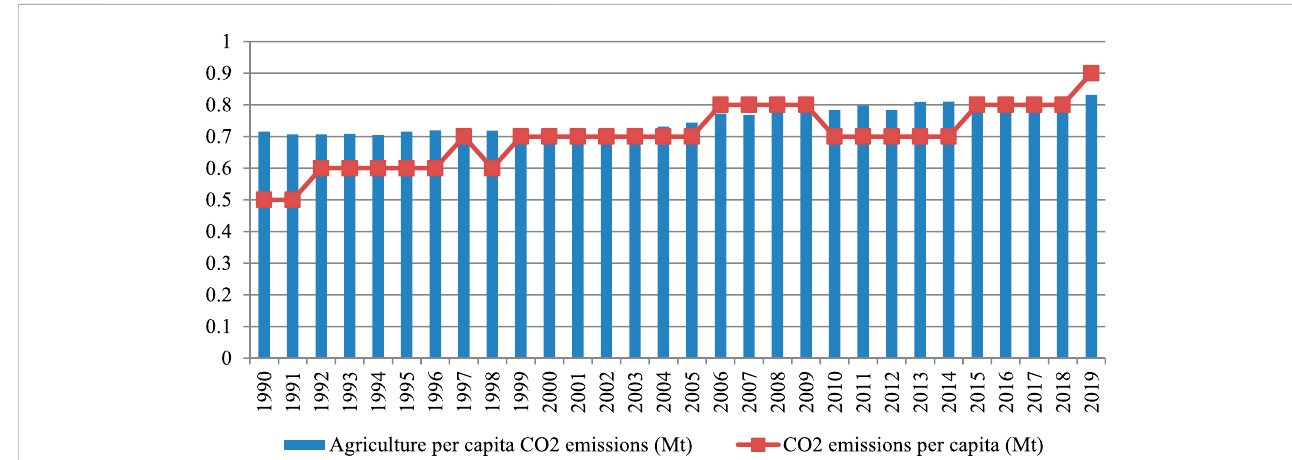
FIGURE 1 Carbon emissions in the agriculture sector and per capita from 1990 – 2019. Source: (IEA, 2019; Lin and Raza, 2021).